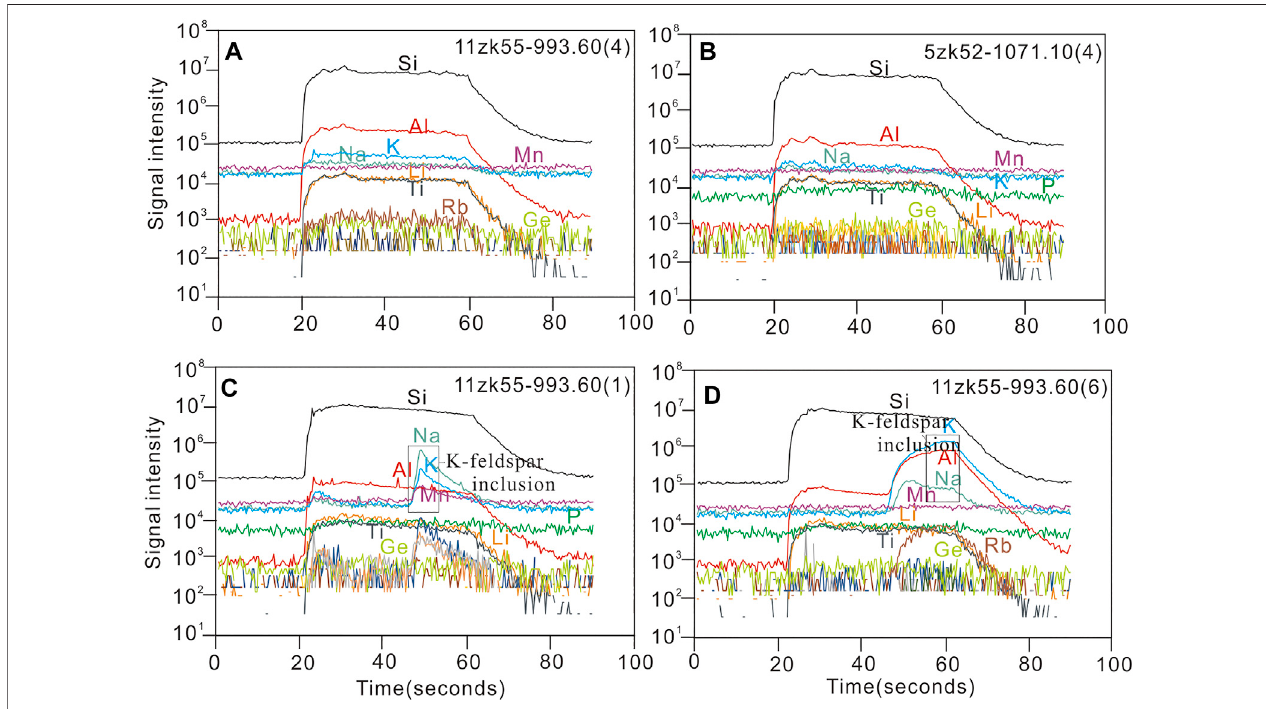
FIGURE 7 | Time-resolved analysis (TRA) of elements across quartz